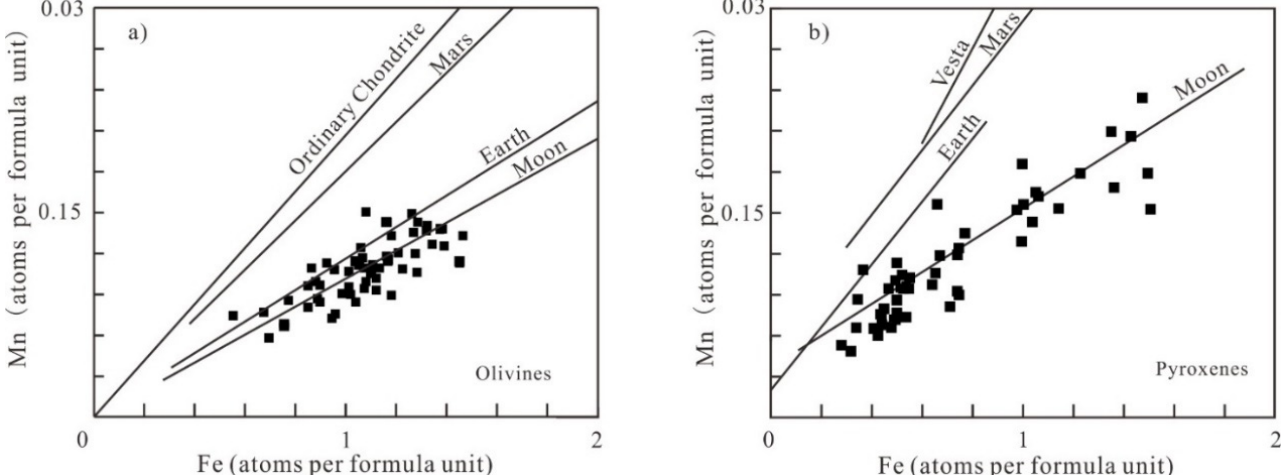
Figure 8. Fe-Mn atomic ratio of olivine ( a ) and pyroxene ( b ) in NWA 13120. The atomic numbers of Fe and Mn in olivine and pyroxene show a linear relationship, distributing near the trend line of lunar samples [6], which is different from the materials of other planets, asteroids or Earth rocks.